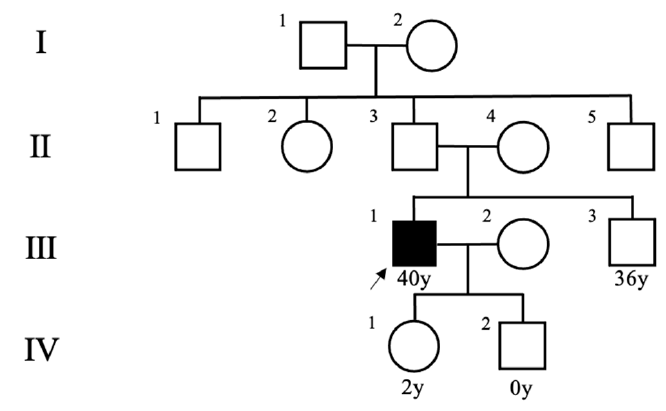
Figure 1. Pedigree of the patient’s family. An arrow indicates the patient.